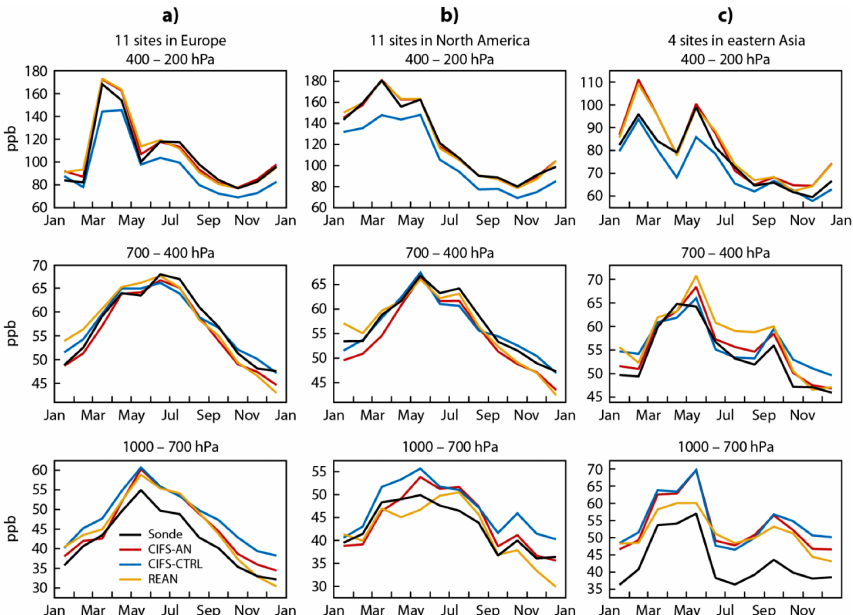
Figure 14. Time series of monthly mean tropospheric O 3 in ppb over (a) Europe (11 stations), (b) North America (11 stations) and (c) eastern Asia (4 stations) averaged in the pressure bands 1000–700hPa (bottom), 700–400hPa (middle) and 400–200hPa (top) from ozonesondes (black), CIFS-AN (red), CIFS-CTRL (blue) and REAN (orange) in